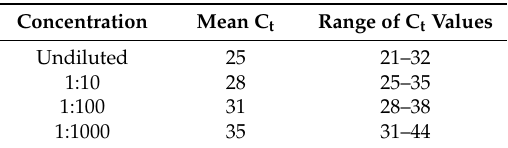
Table 5. Summary limit of detection (LOD) results.